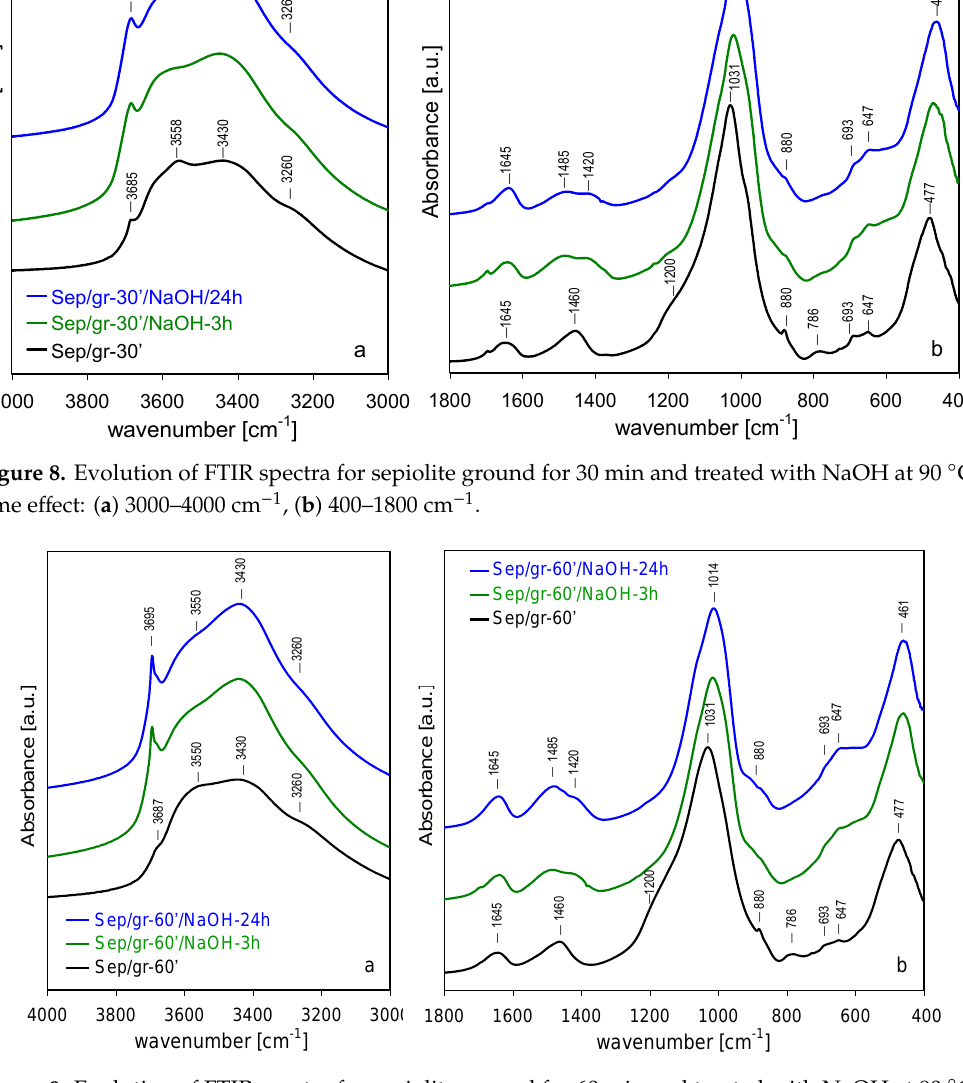
Figure 9. Evolution of FTIR spectra for sepiolite ground for 60 min and treated with NaOH at 90 °C, time effect: ( a ) 3000–4000 cm − 1 , ( b ) 400–1800 cm − 1 .